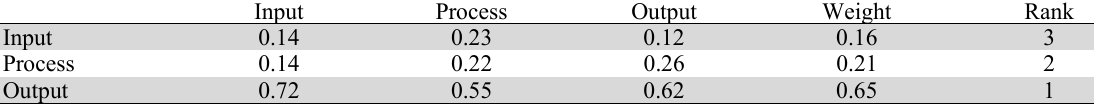
Normalized Matrix and weight of factor production to goal ECW